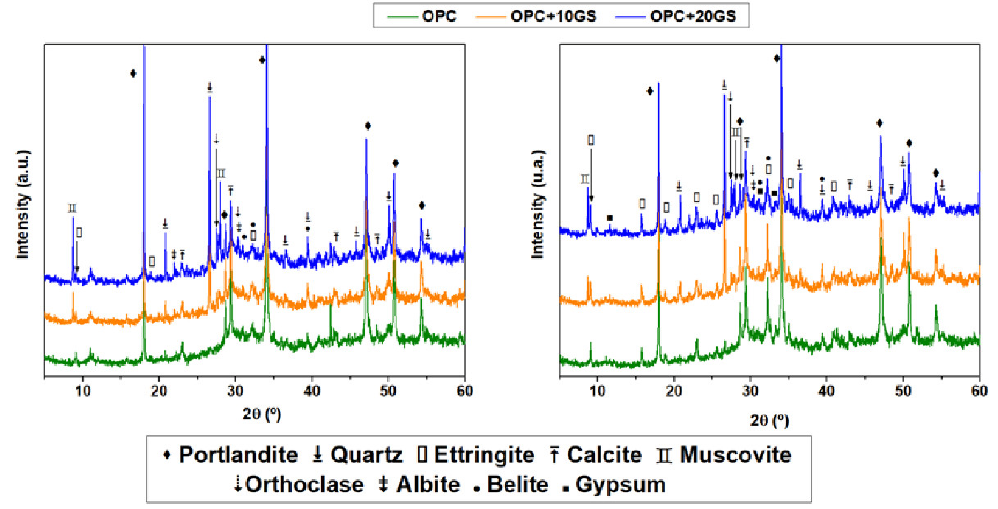
Figure 8. XRD patterns for pastes OPC, OPC + 10GS, and OPC + 20GS soaked for 180 days in ( left ) water and ( right ) sulfates.